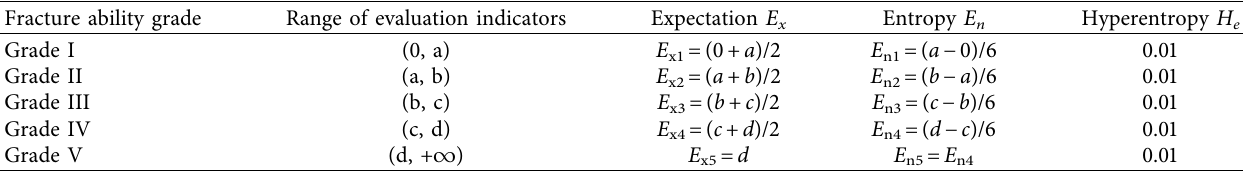
Table 8: Calculation method about digital characteristics of the cloud.